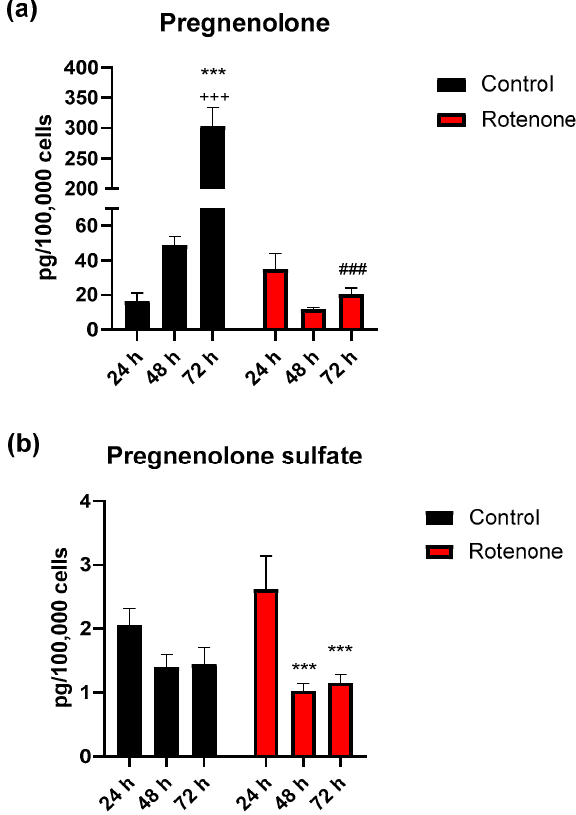
Figure 4. Pregnenolone ( a ) and pregnenolone sulfate ( b ) concentrations in BV-2 cells’ medium determined by LC-MS/MS in microglia, in resting condition (Control) or after activation by exposure to rotenone at different time intervals (24, 48 and 72 h). Data represent the average of 2 independent experiments ( n = 5) and are expressed in pg/100,000 cells (mean values ± SEM). Statistical analysis was by two-way ANOVA and Holm-Šídák post hoc test. Pregnenolone: *** p < 0.001, vs 24 h control; +++ p < 0.001, vs 48 h control; ### p < 0.001, vs same time interval of control. Pregnenolone sulfate: *** p < 0.001, vs 24 h rotenone.